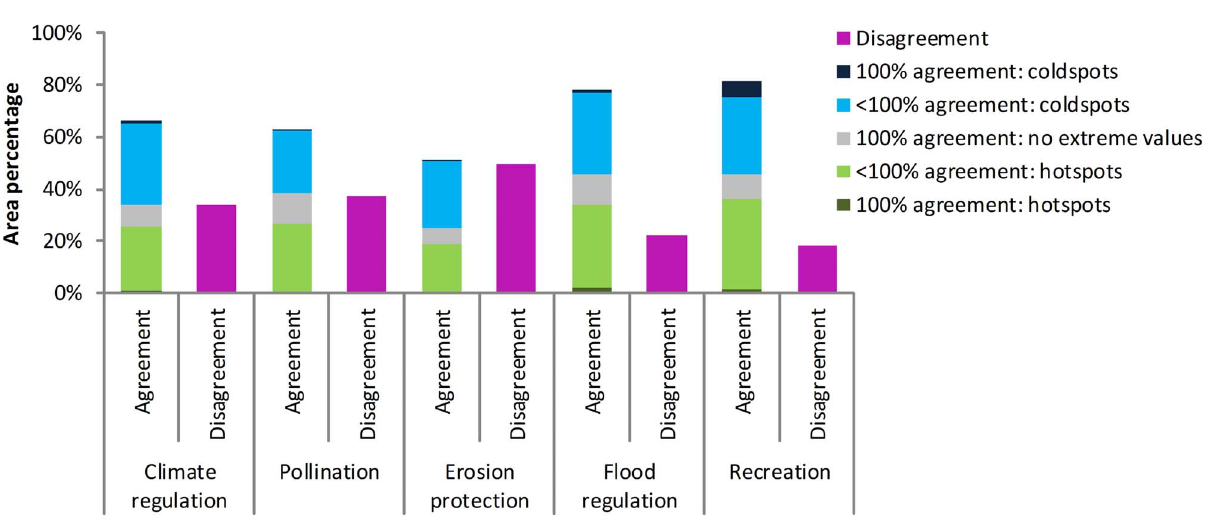
Figure 4. Agreement between the ecosystem service maps. 100% agreement indicates the area where all maps indicate a hotspot, a coldspot or no extreme values, , 100% agreement indicates regions where one to three of the maps have a hotspot or coldspot and the other maps do not demonstrate extreme values. Disagreement indicates the regions where at least one map indicates a hotpot and at least one other map indicates a